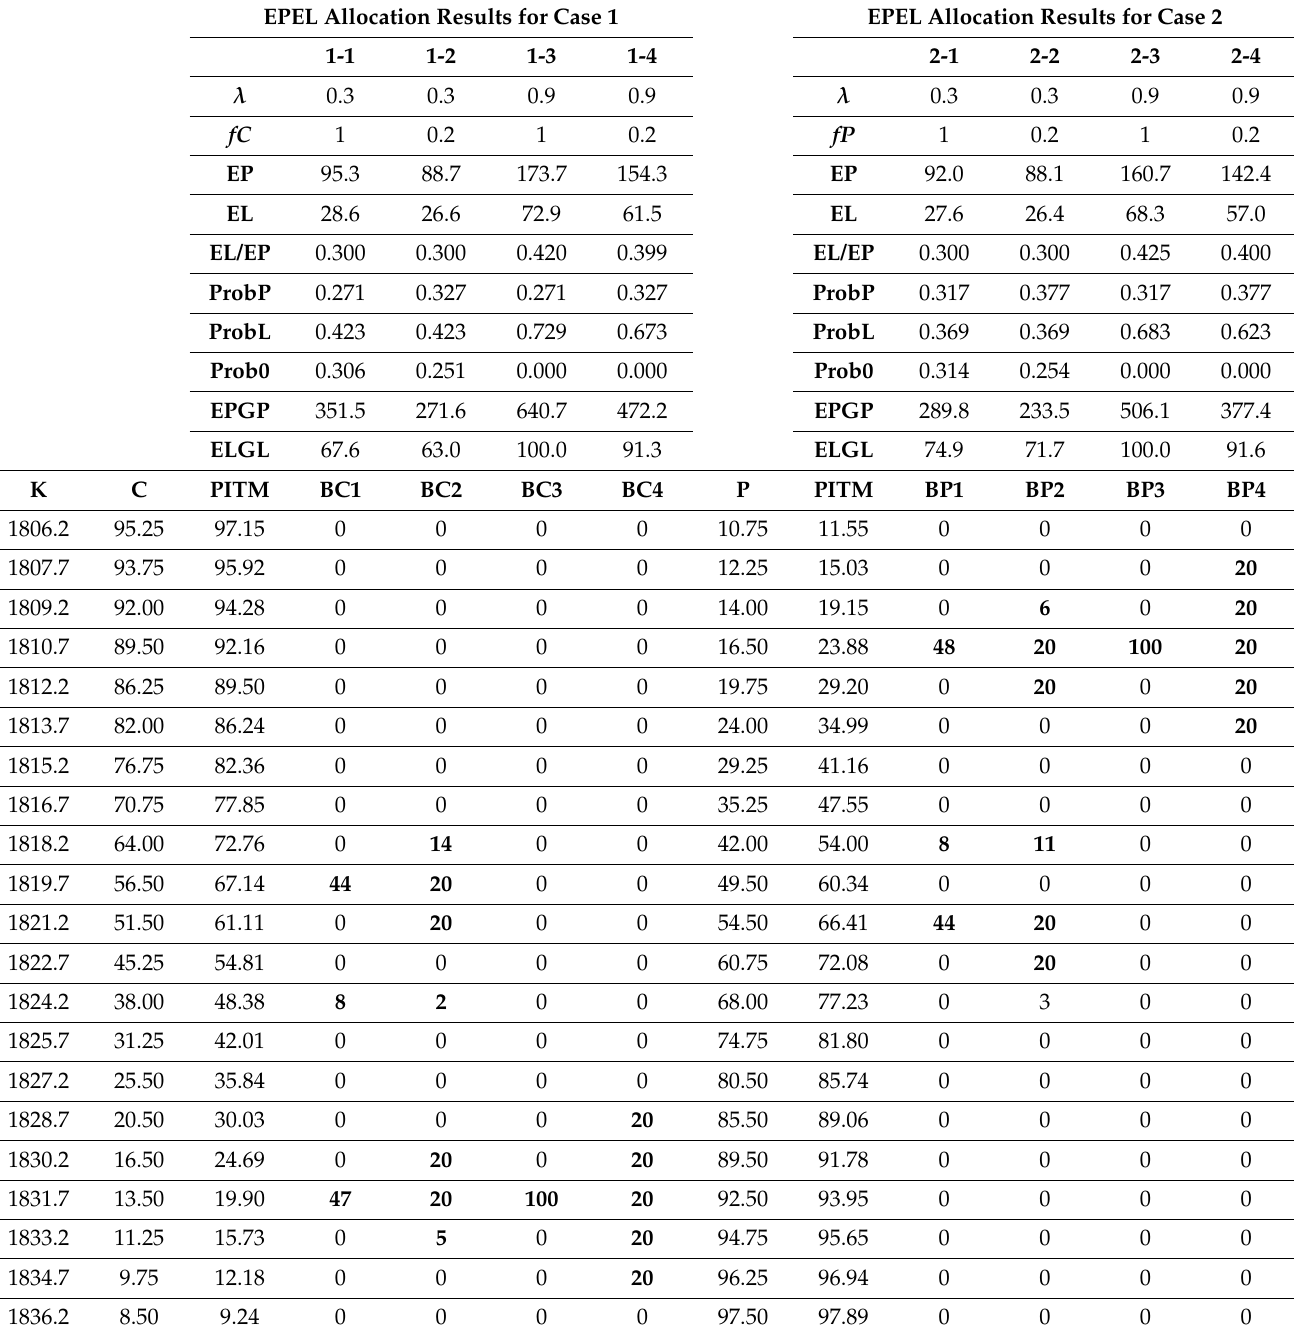
Table 3. EPEL binary portfolio allocations and features for Case 1 (left block) and Case 2 (right block). In Case 1 µ = 0.0022 and in Case 2 µ = − 0.0038. In both cases σ = 0.0051 and S 0 = 1822. Results based on Nadex gold binary data of 8 February